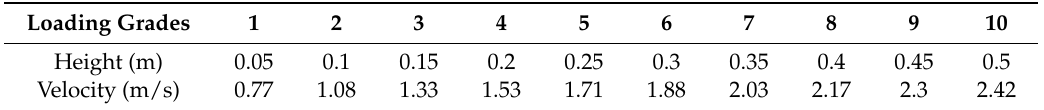
Table 2. Impact velocities of the iron